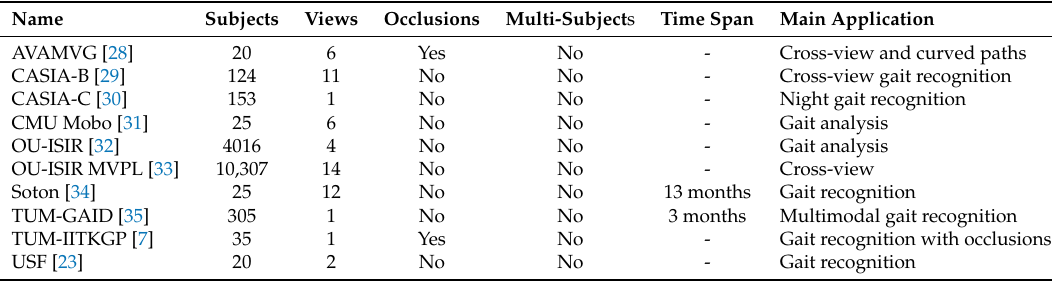
Table 1. Comparison of state-of-the-art gait